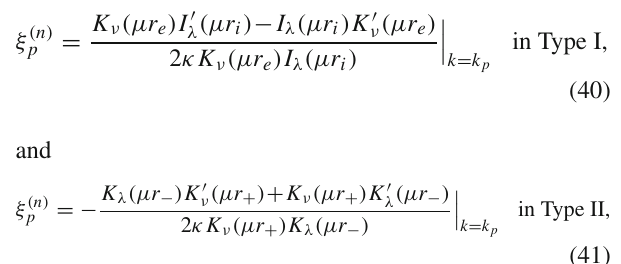
( a ) Negative κ thin-shell configuration is stable for ξ>ξ (0) c . Fig. 1 Safety domains, in grey, for the massive coupled scalar field Green’s function in Type I spacetimes with mr i = 1. The curves represent the ( n ) function ξ p for different n